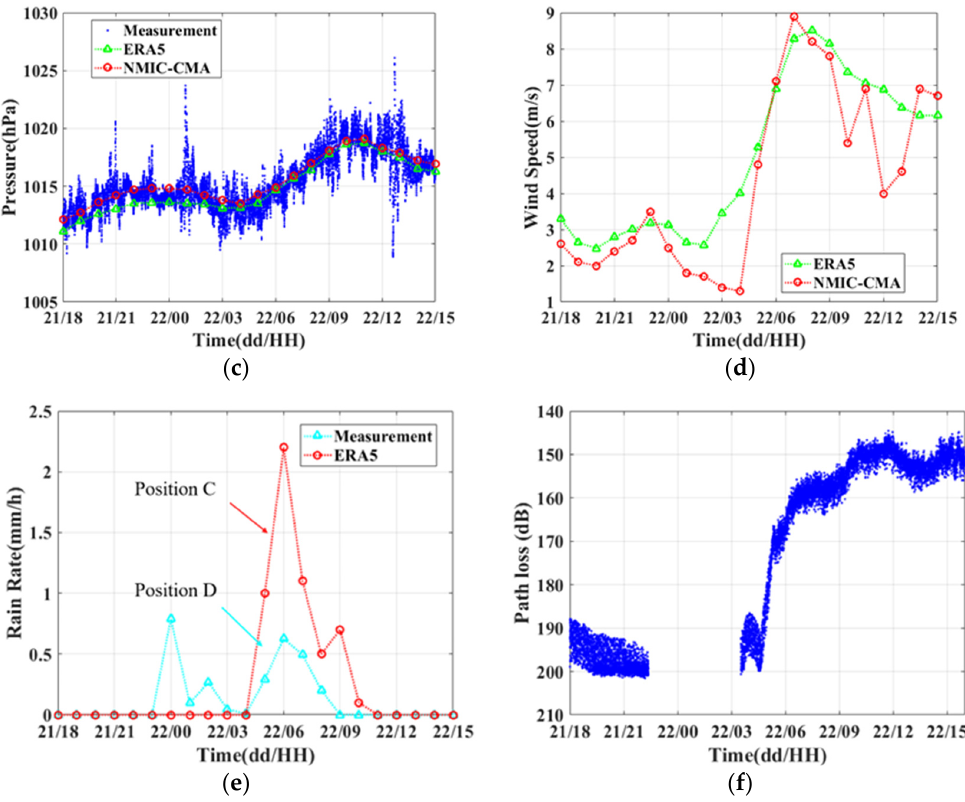
Figure 7. Comparison of the meteorological parameters from three different data sources during the study period, including AT ( a ); RH ( b ); pressure ( c ); WS ( d ); RR ( e ); PL ( f ).